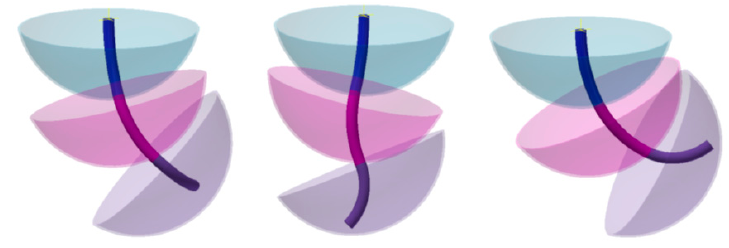
Figure 5. Range of motion of the three segments. Source: authors.